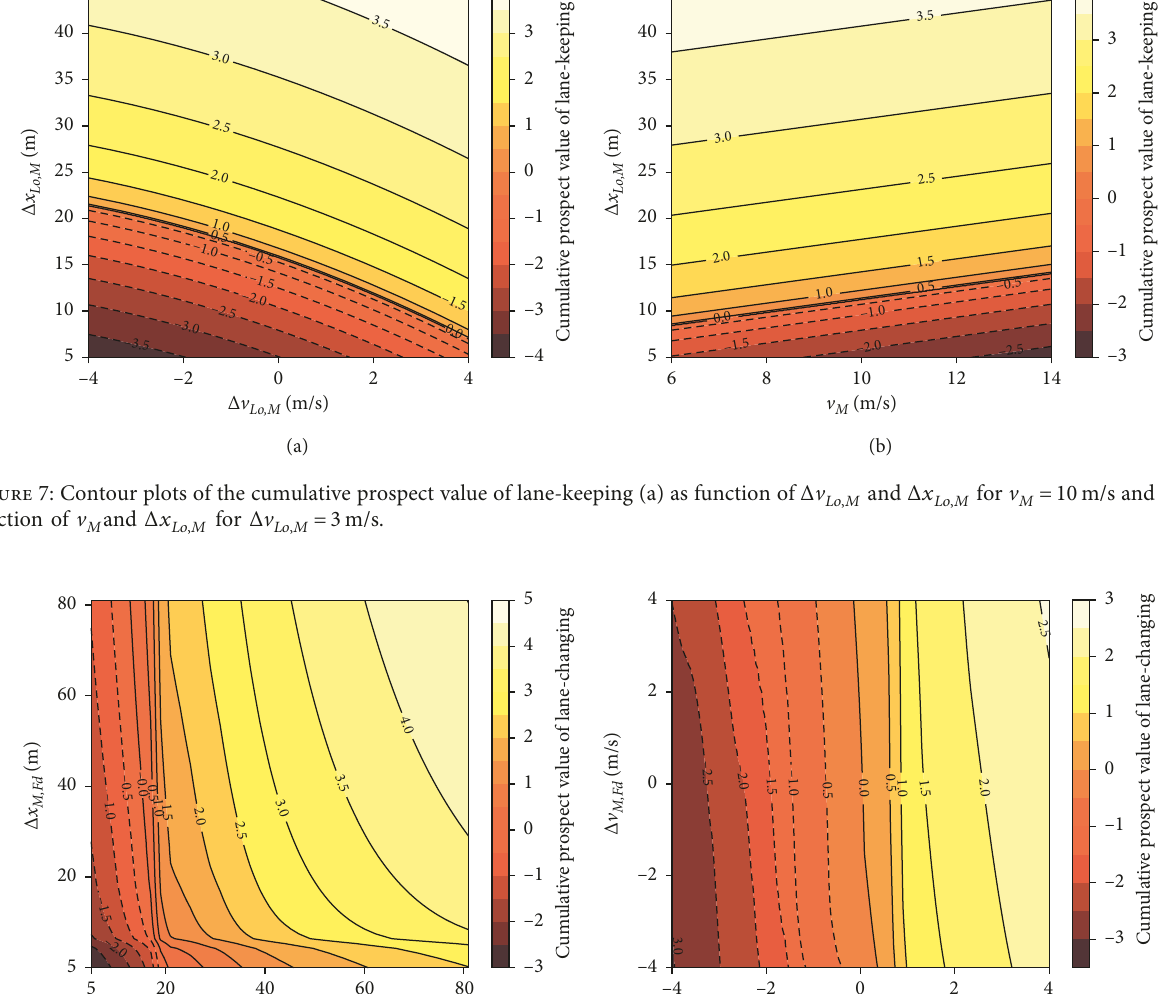
Figure 8: Contour plots of the cumulative prospect value of lane-changing (a) as function of v v v v M (cid:28) Ld (cid:28) Lo (cid:28) Fd (cid:28) 10m/s and (b) as function